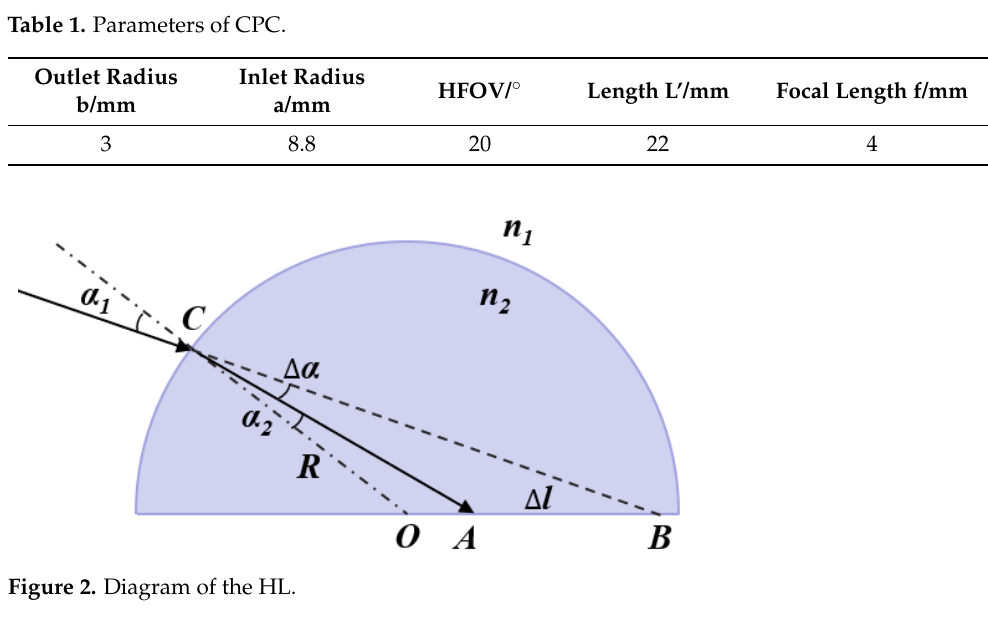
Figure 2. Diagram of the HL. Table 1. Parameters of